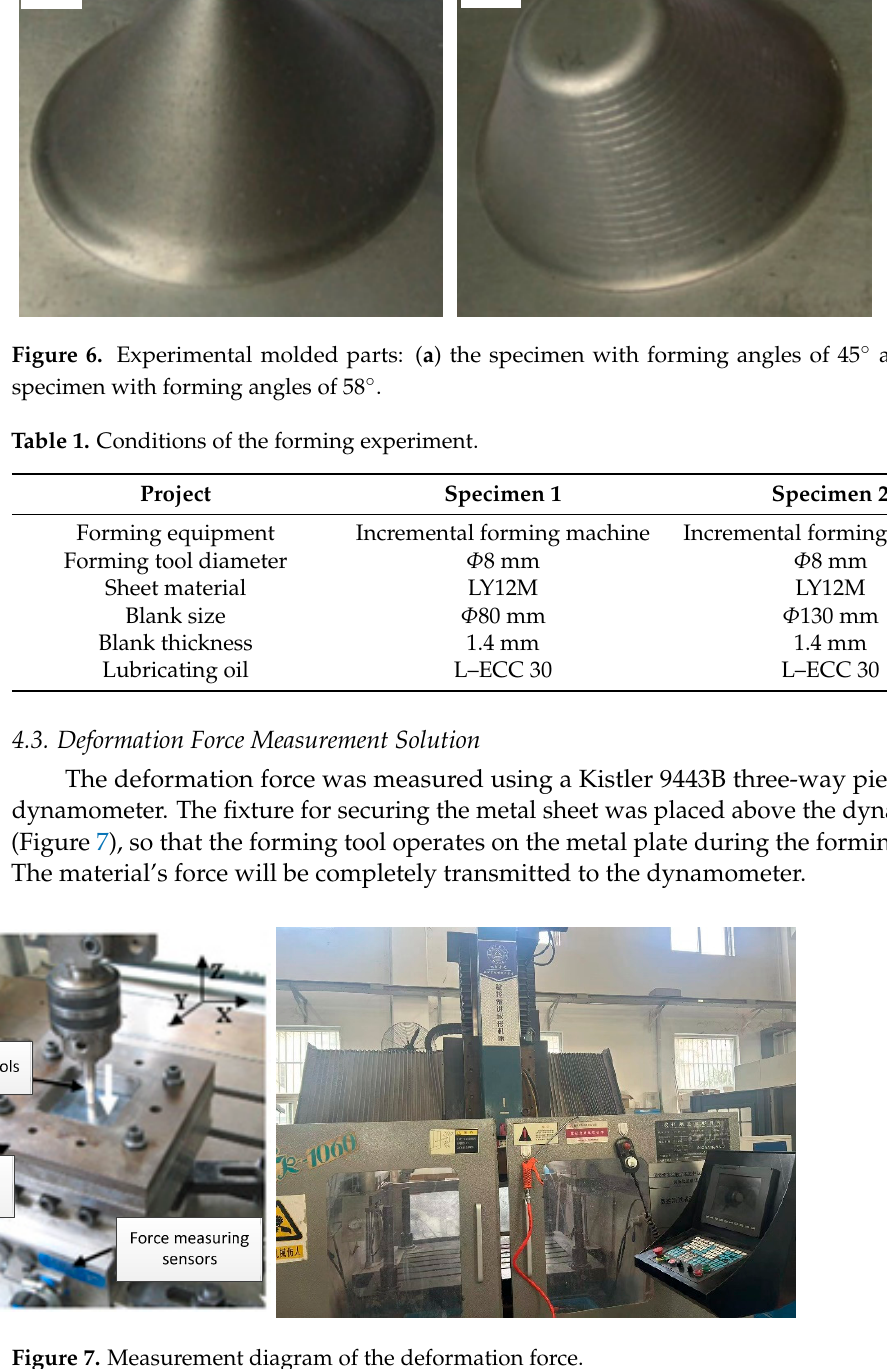
Figure 6. Experimental molded parts: ( a ) the specimen with forming angles of 45° and ( b ) the specimen with forming angles of 58°.